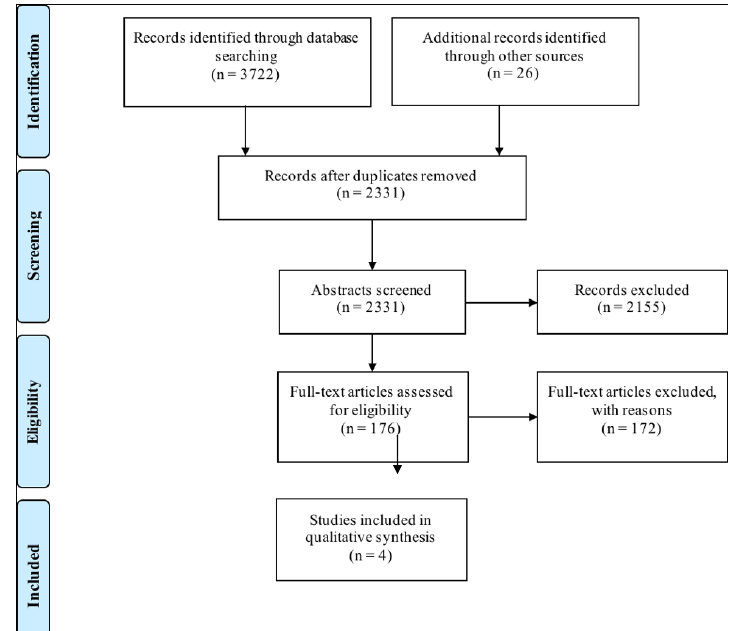
Figure 1. A Preferred Reporting Items for Systematic Reviews and Meta-Analyses (PRISMA) flow diagram depicting the process of retrieving articles for the current systematic review to explicitly indicate the number of records identified, included, and excluded at each stage [33].